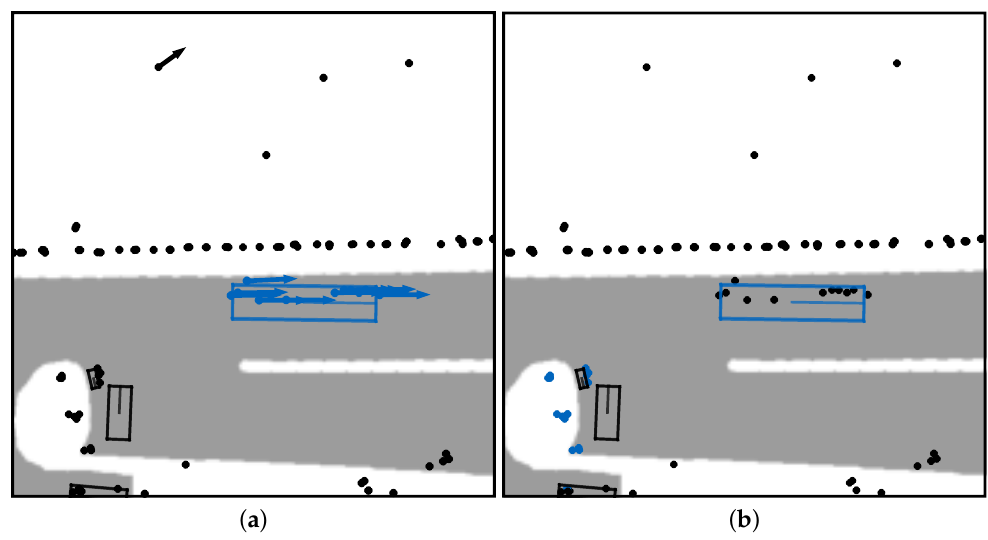
Figure 8. Classification of a moving vehicle. Ground-truth bounding boxes and radar classifica- tions are color-coded. Blue: moving vehicle. Black: rest. The segmentation in ( a ) is more precise than the segmentation in ( b ) due to the inclusion of velocity features. NuScenes sample token: